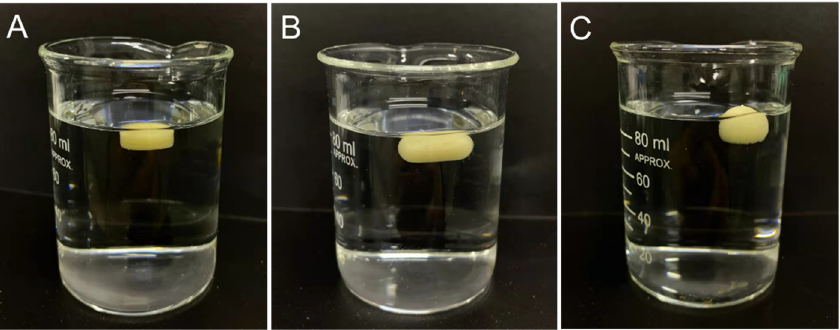
Figure 9. In vitro floating of the cylinder ( A ), capsule ( B ) and hemisphere ( C ) formulations at 0 h (without floating lag time).